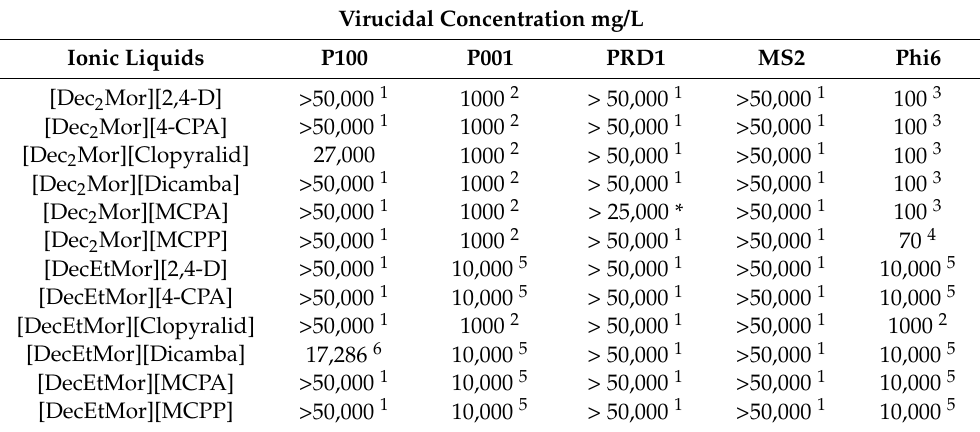
Table 1. Virucidal concentration [mg/L] (including upper and lower limits) of the 12 ILs. Virucidal Concentration